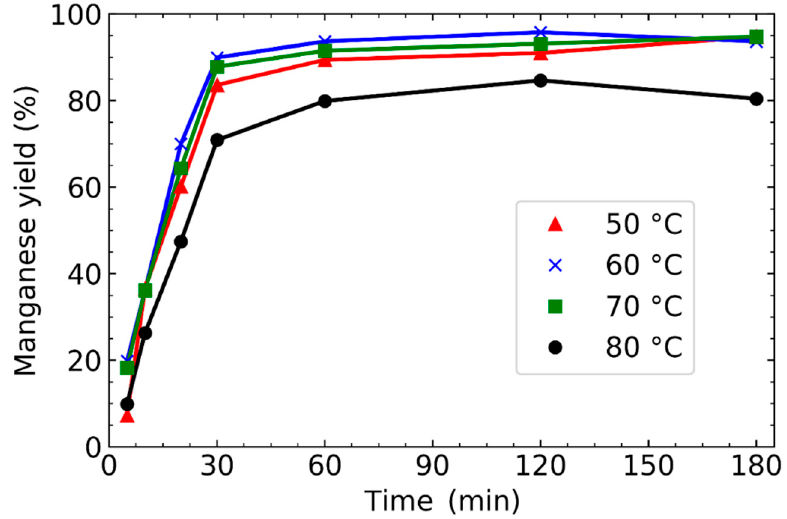
Figure 4. Manganese yield as a function of time at 50, 60, 70 and 80 °C (S/L ratio 420 g/L, Citric. acid).